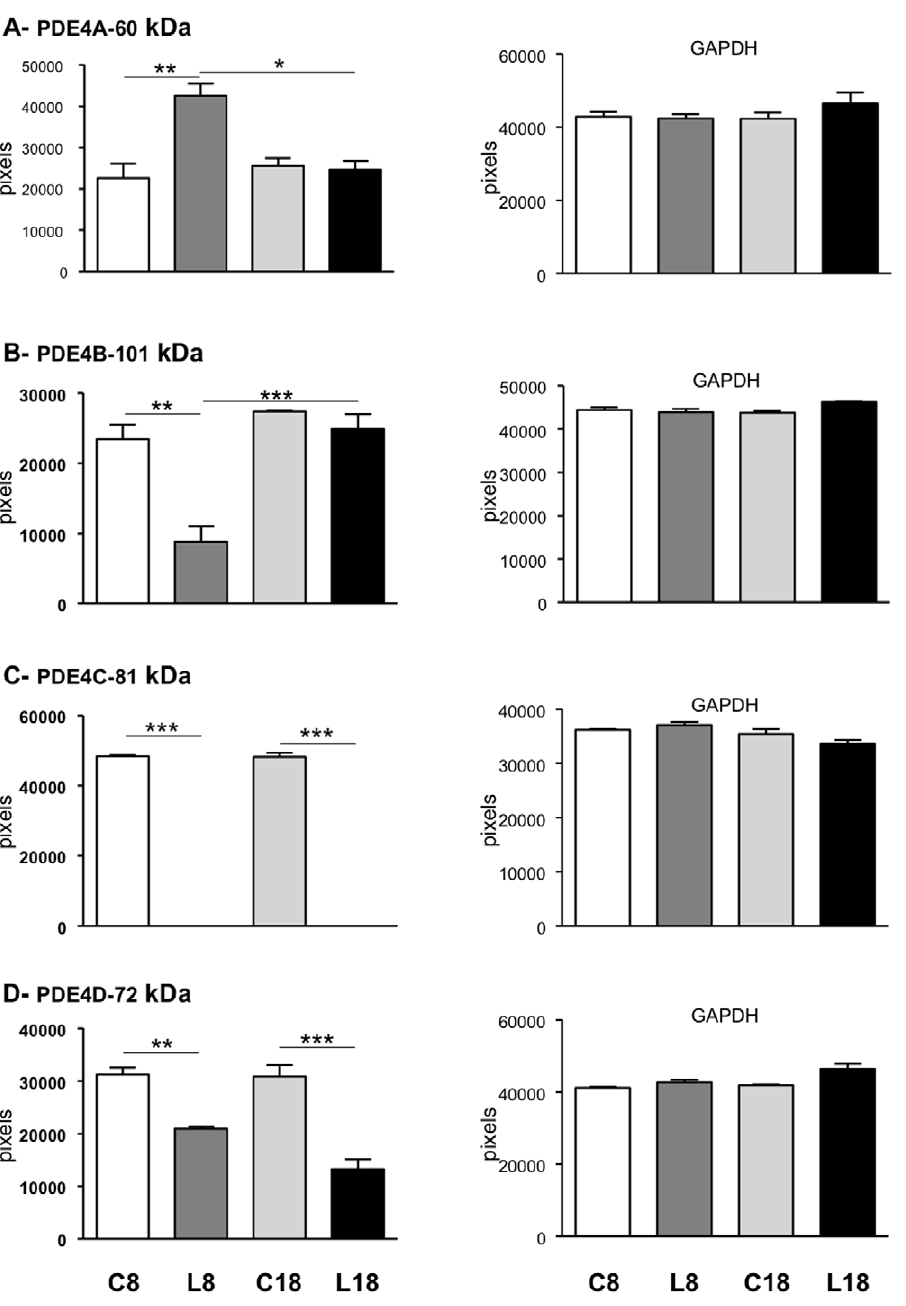
Figure 4. Protein expression pattern of PDE4 in kidneys of MRL/lpr mice of 8 and 18 weeks. PDE4A, PDE4B, PDE4C, PDE4D and GAPDH protein expressions were assessed on 8 week-old (C8) and 18 week-old (C18) CBA/J control mice and 8 week-old (L8) and 18 week-old (L18) MRL/lpr mice. Data are the mean 6 s.e.m. of three mice.*, P , 0.05; **, P , 0.01; ***, P , 0.001.